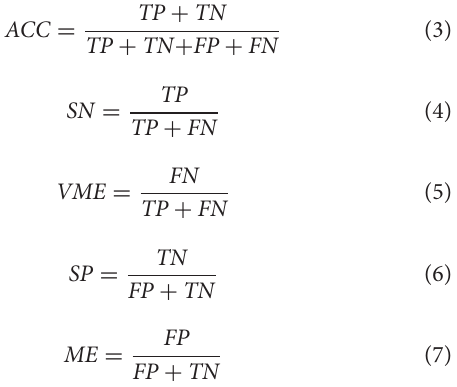
gets training sets and attributes. As illustrated in Supplementary Figure 3 , the ensemble learning method trains multiple